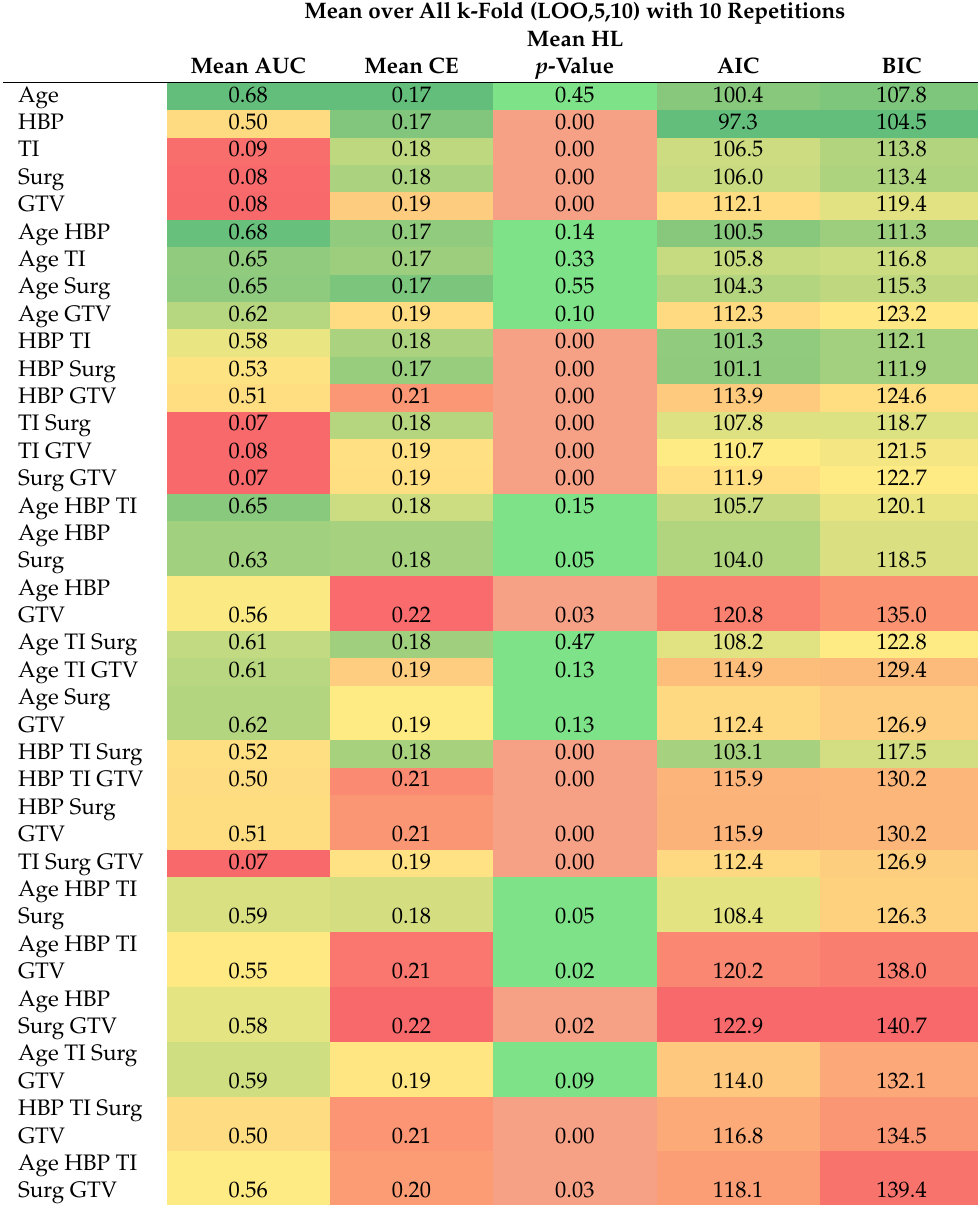
Table A1. The detailed overview of the cross-validation results. Mean over All k-Fold (LOO,5,10) with 10